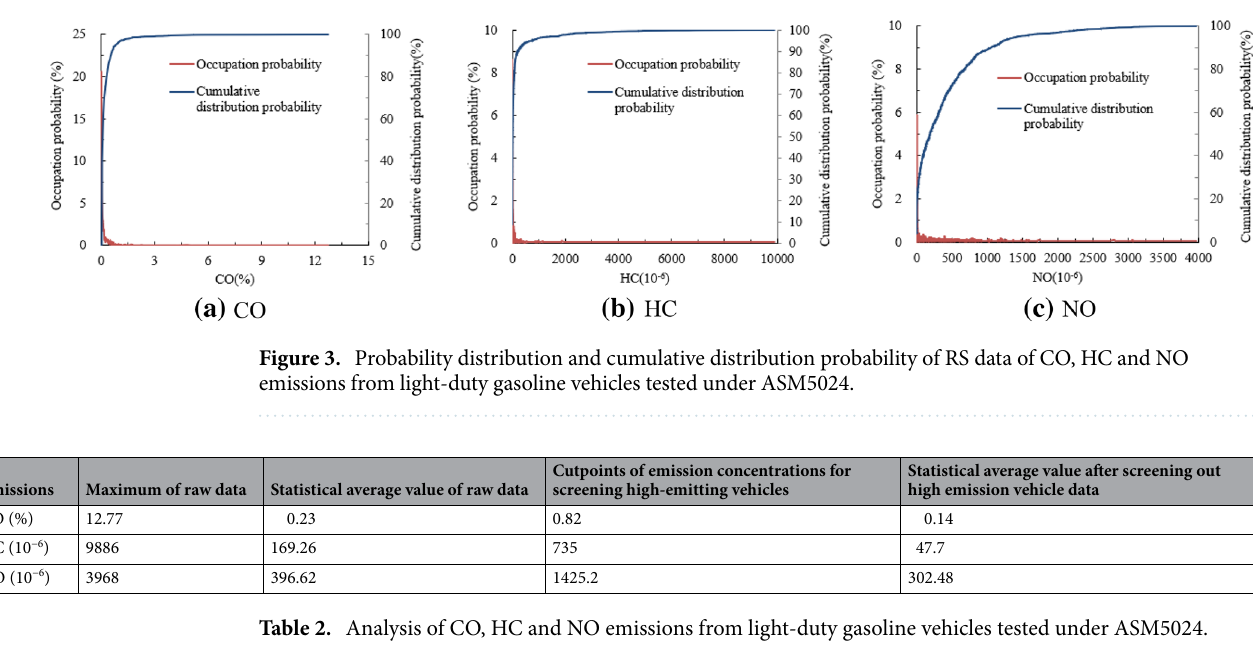
Table 2. Analysis of CO, HC and NO emissions from light-duty gasoline vehicles tested under ASM5024.